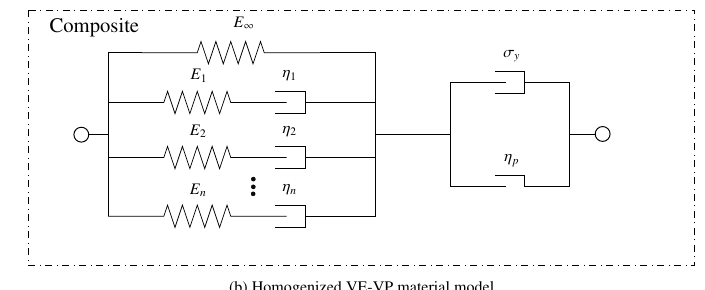
Figure 28: The equivalent homogeneous model with a VE-VP model (b) is assumed to have the same mechanical behavior as the RVE model with Figure 28. A comparison of the stress–strain relation of monotonic loading for six different strain rates between RVE heterogeneous material in (a). The parameters in (b) have to be determined by homogenization of the RVE model [ ? ]. simulation and the homogenized numerical model